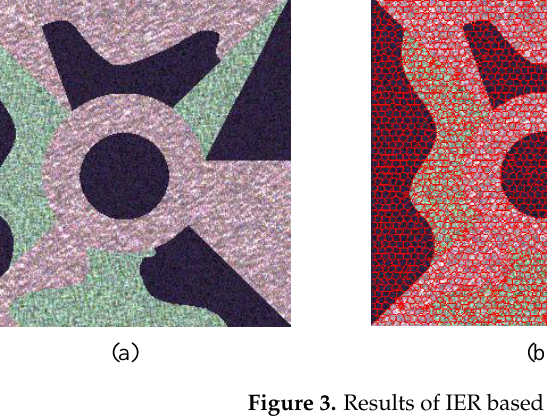
Figure 3. Results of IER based on hexagonal initialization (i.e., Hex-IER). ( a ) Pauli-RGB image of the simulated PolSAR image. ( b ) Generated superpixels of Hex-IER. ( c ) The unstable-pixels-to-all-pixels ratio of